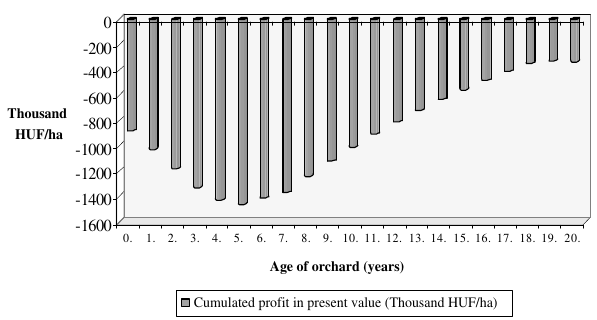
Figure 1: The Cumulated Discounted Profit (NPV) of the Sour Cherry Orchard during the Life-Time (r =